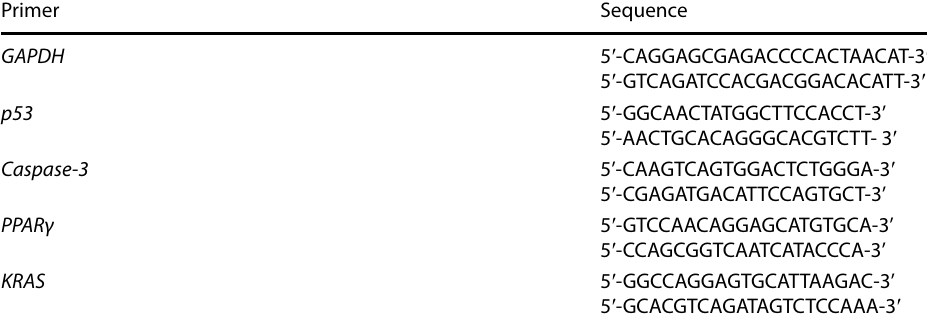
Table 1 Primer sequences of investigated